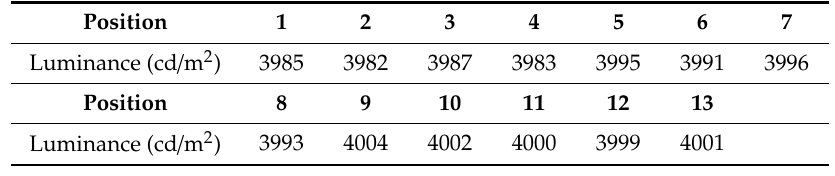
Table 4. Uniformity of the luminance screen.